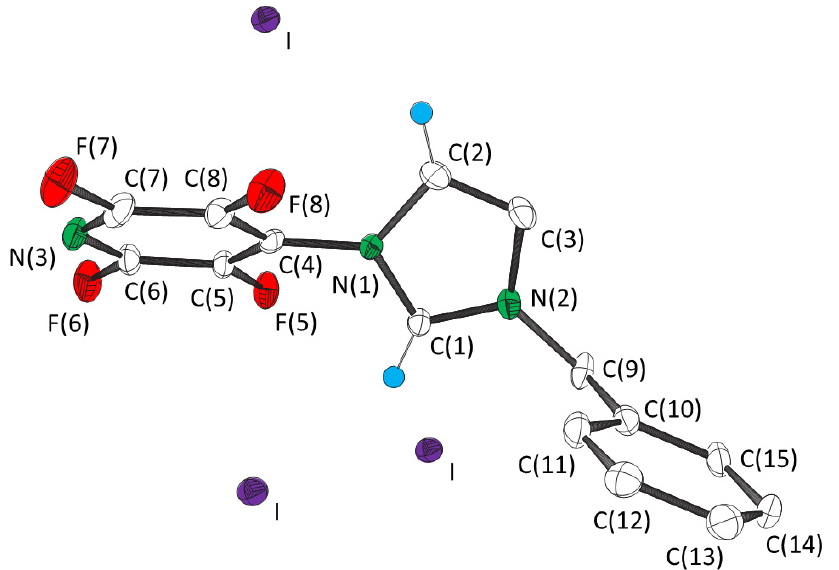
Figure 2. The structure the cation of 1-(2,3,5,6-tetrafluoro-4-pyridyl)-3-benzylimidazolium iodide ( 3 ) indicating the positions of the three closest iodide anions. Thermal ellipsoids are at the 50% level. Hydrogen atoms not involved in hydrogen bonding are omitted for clarity.